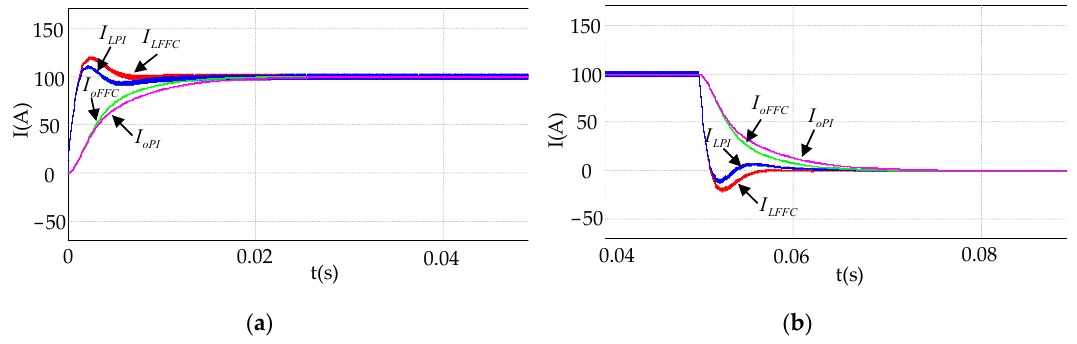
Figure 11. Waveforms of start-up and turn-off processes in charging mode. ( a ) Start-up waveform from 10% to 90% with PI and duty ratio feedforward control methods. ( b ) Turn-off waveform from 10% to 90% with PI and duty ratio feedforward control methods.